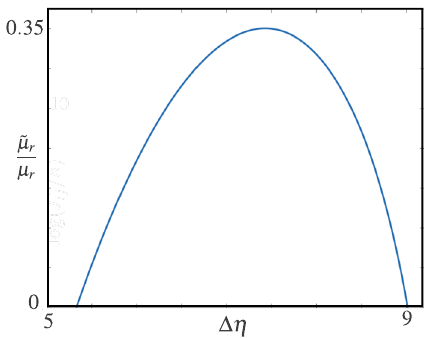
FIG. 7. Dressed shear modulus: ratio of the dressed shear modulus, Eq. (126), and the original shear modulus, Eq. (79), of the parametrically driven crystal of 171 Yb + ions, as a function of the relative modulation amplitude (cid:10)η in Eq.